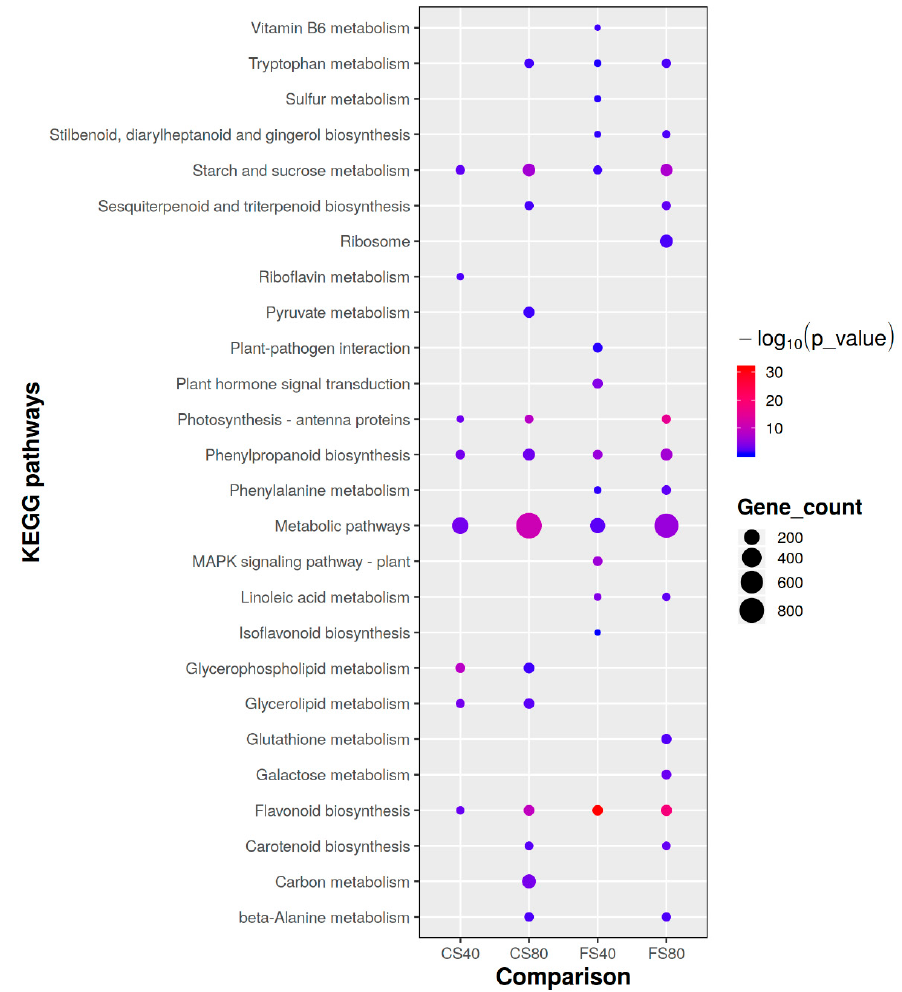
Figure 4. Comparison of enriched metabolism pathways of DEGs induced by shade stress in peanut plants. Only the significantly affected (hypergeometric test p < 0.05) involved by shade induced DEGs were plotted here. The pathways information is from the database KEGG (https://www.genome.jp/kegg/). FS40, FS80, CS40, and CS80 represent DEGs, relative to control under natural sunlight, mined from shade treatments of 40% shade at flowering stage for 30 days, 80% shade at flowering stage for 30 days, 40% shade from seeding stage for 30 days to flowering stage for another 30 days, 80% shade from seeding stage for 30 days to flowering stage for another 30 days, respectively. Three experiments were conducted, each with three plants.